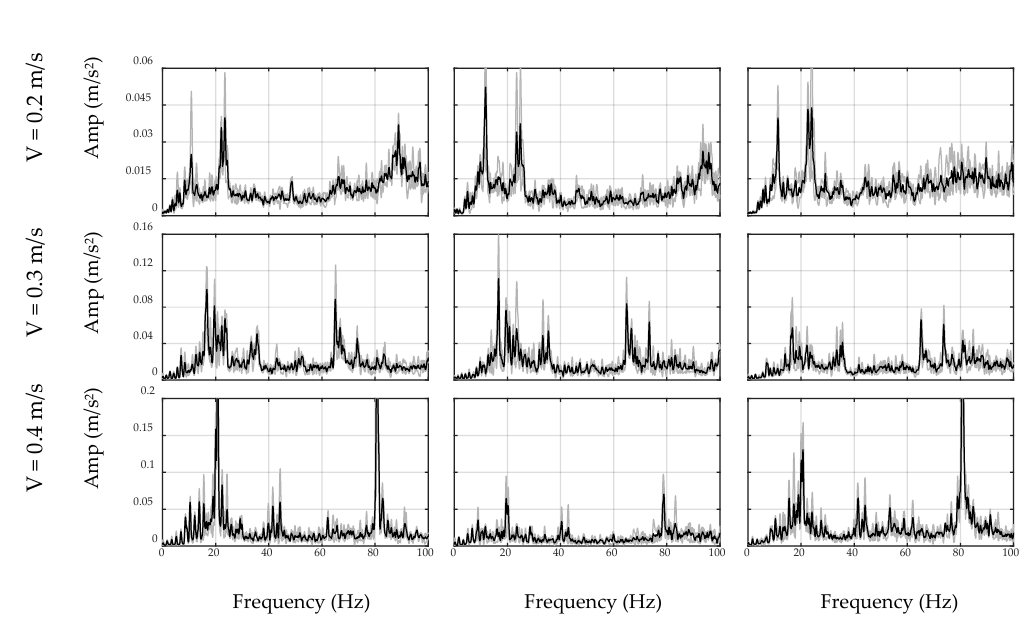
Figure 12. ADFT spectrums of off-bridge signals recorded by sensor.